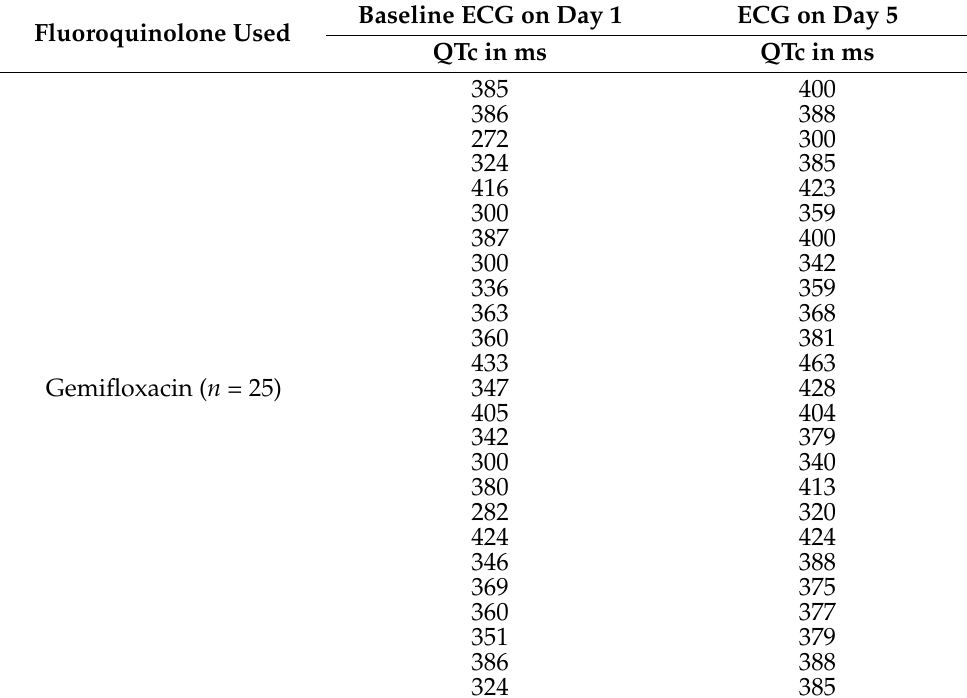
Table 4. QTc interval measured in milliseconds in twenty-five participants treated with